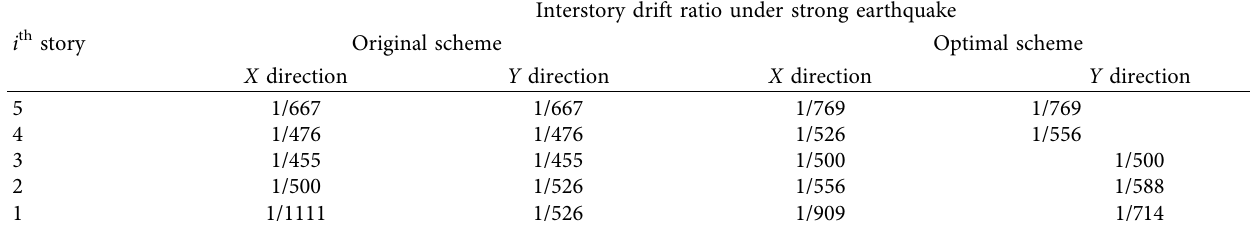
Table 2: Interstory drift ratio in the optimal and original scheme.